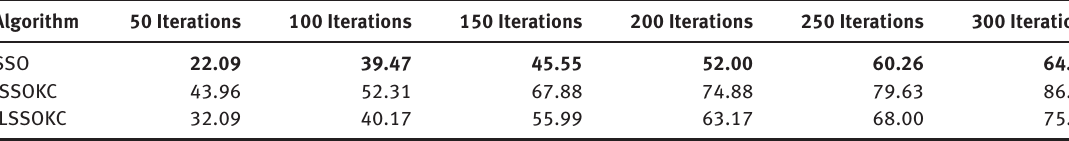
Table 11: CPU Time-Elasped Comparison: Proposed Algorithms (Vowel Data Set).